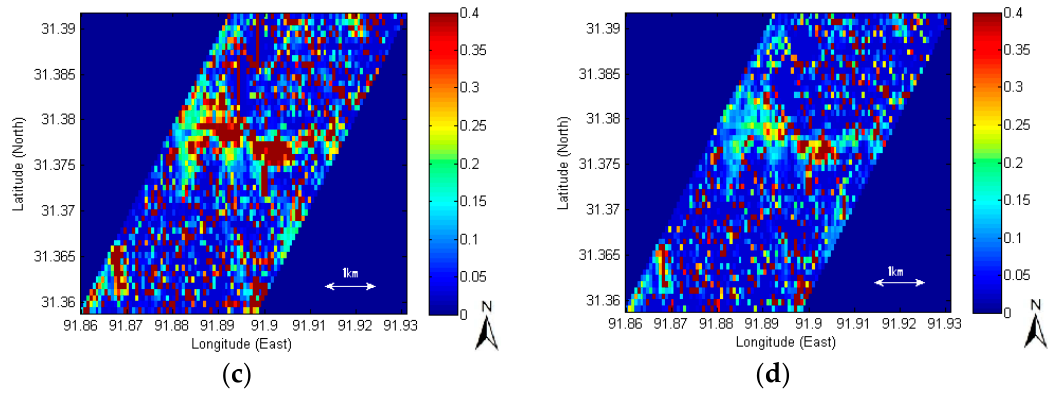
Figure 4. Backscattering experiments: ( a ) soil moisture retrieved from original ASAR backscattering; ( b ) original ASAR backscattering; ( c ) soil moisture retrieved from the hypothetical ASAR backscattering error of +1 dB; and ( d ) soil moisture retrieved from the ASAR hypothetical backscattering error of –1 dB on DoY 221. The unit for (a), (c), and (d) is m 3 /m 3 and the unit for (b) is dB. In any the ASAR backscattering error schemes, the overestimation of SAR retrievals over the dry area was similarly found, as indicated by several red points in Figures 4c,d. Rather, those